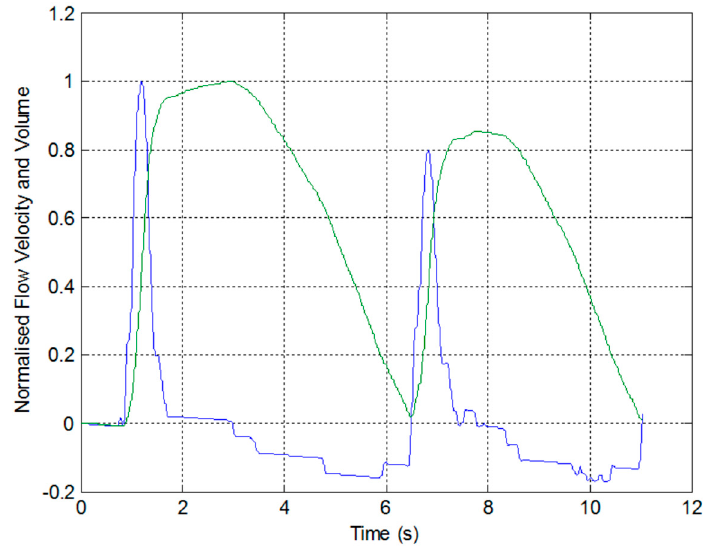
Figure 20. Normalised flow velocity and flow volume obtained from the recorded data produced by the low-cost sensor.